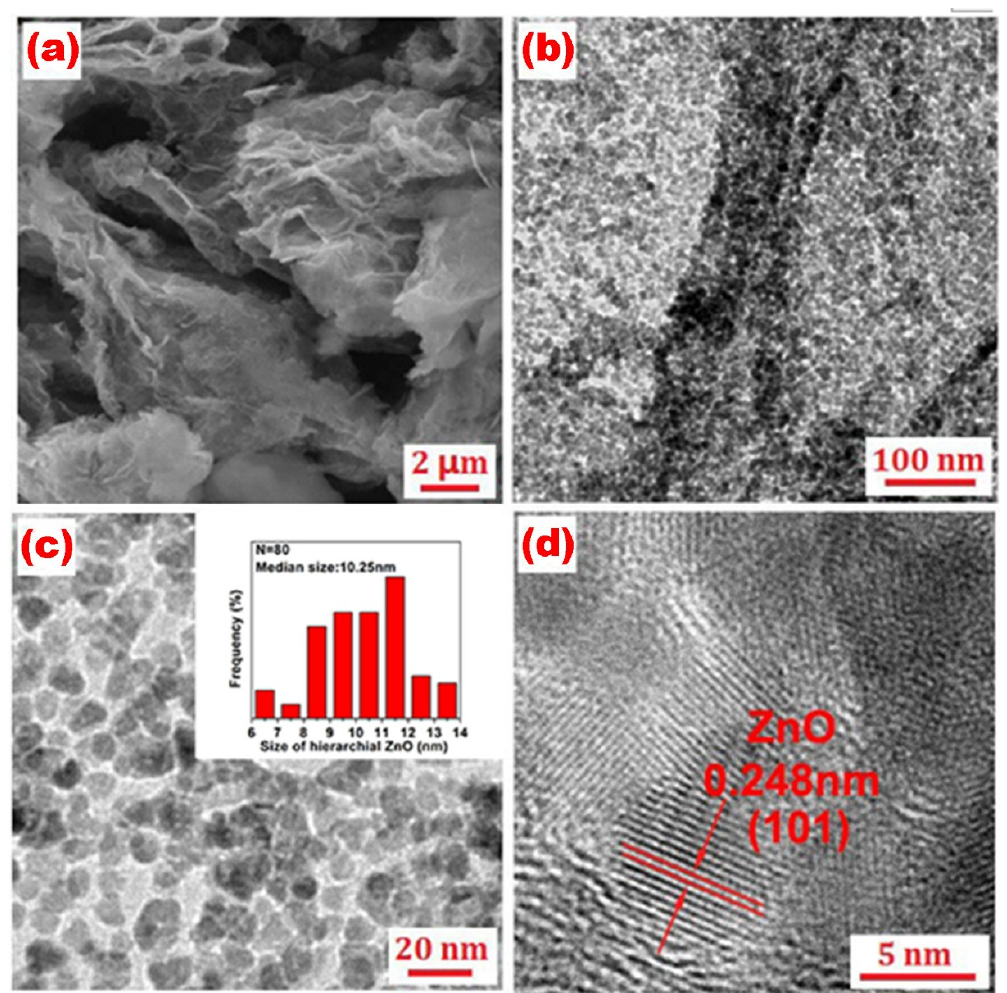
Figure 3. ( a ) SEM image of the ZnO/NDG composite. ( b ) TEM image of the ZnO/NDG composite. ( c ) Low-magnification TEM image for ZnO/NDG composite. The inset shows the particle size distribution of ZnO. ( d ) HRTEM image of the ZnO/NDG composite.